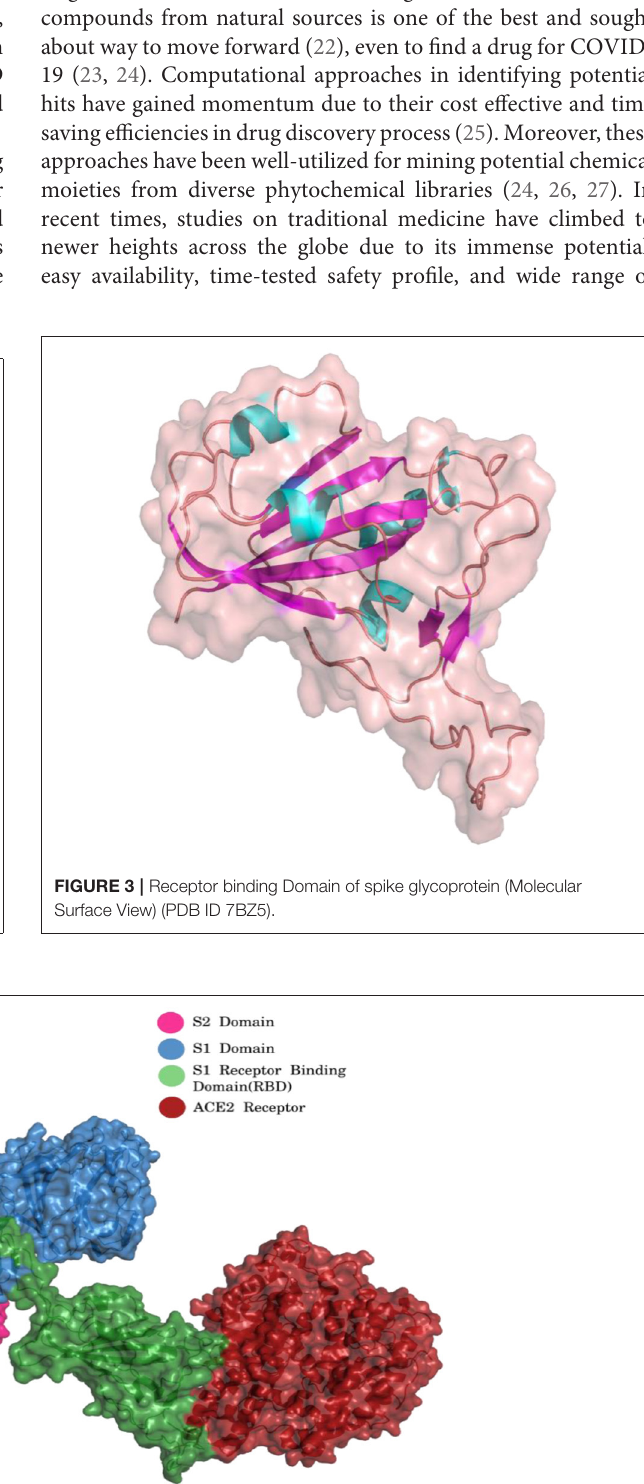
Frontiers in Medicine |